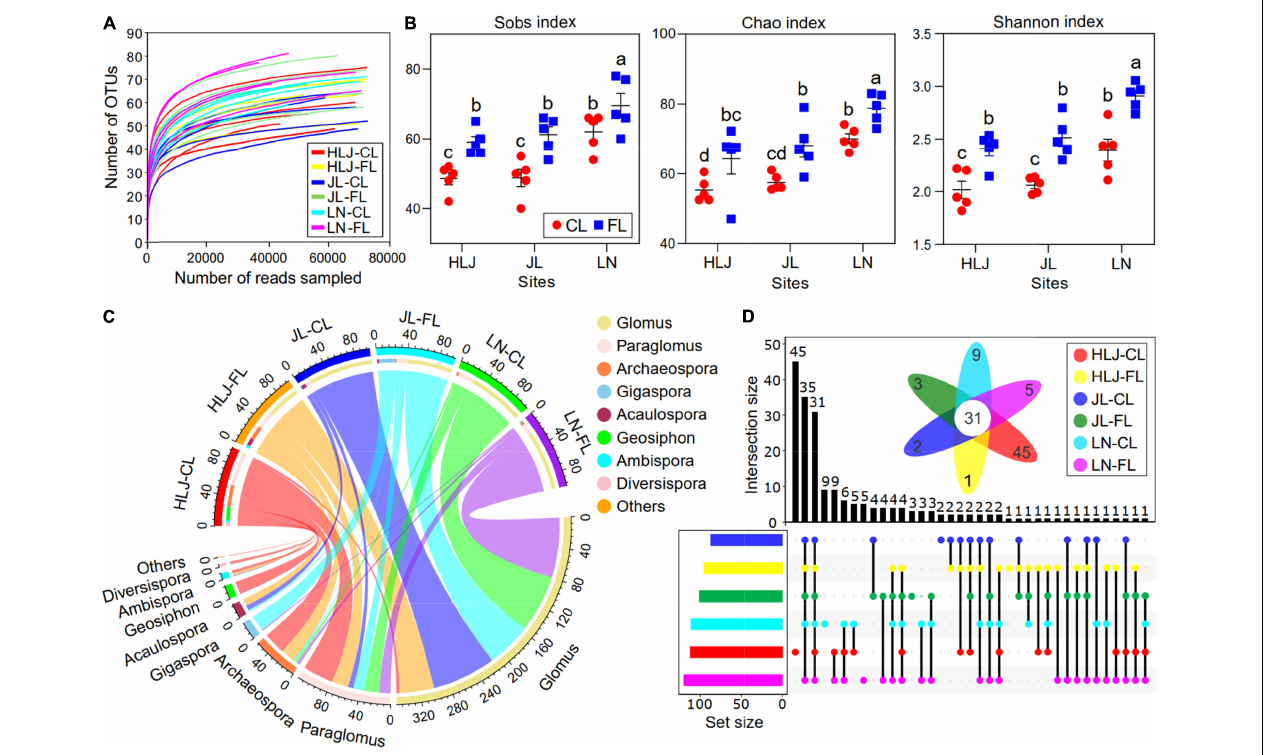
FIGURE 1 | Composition and diversity of the AMF community under CC and LUC. (A) Rarefaction curves of the observed OTU number of AMF; (B) box plots representing α -diversity indices at the OTU level, including Sobs, Chao, and Shannon indices under different treatments; (C) circos diagram depicting the top AMF composition at the genus level with treatment; and (D) upset plots showing the relationships of AMF genus in different treatments. The colored bars on the left panel indicate the number of genera that are uniquely shared in each sample. The numbers above the bars show the number of common genera among the groups of samples marked below the bars. A Venn diagram of shared and unique genera is shown. CL, cropland; FL, fallow